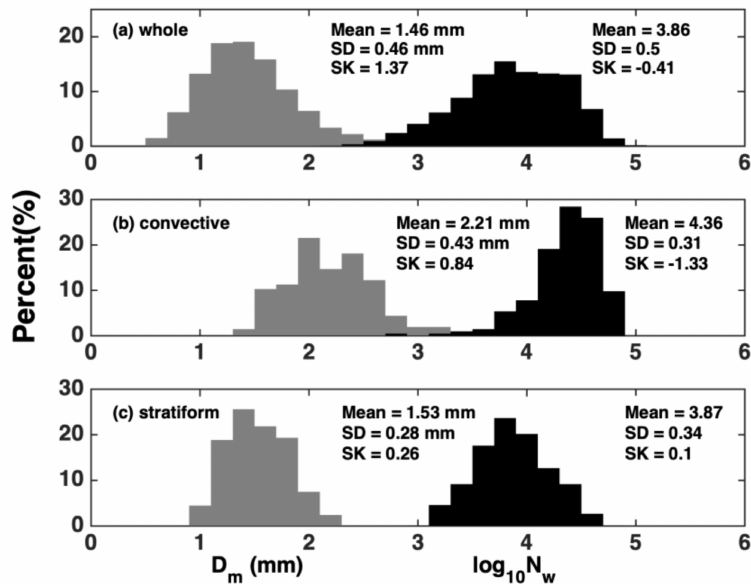
Figure 3. Histogram of D m (left side) and log 10 N w (right side) for the ( a ) whole data set and ( b ) convective and ( c ) stratiform subsets calculated from the OTT Parsivel 2 disdrometer datasets.